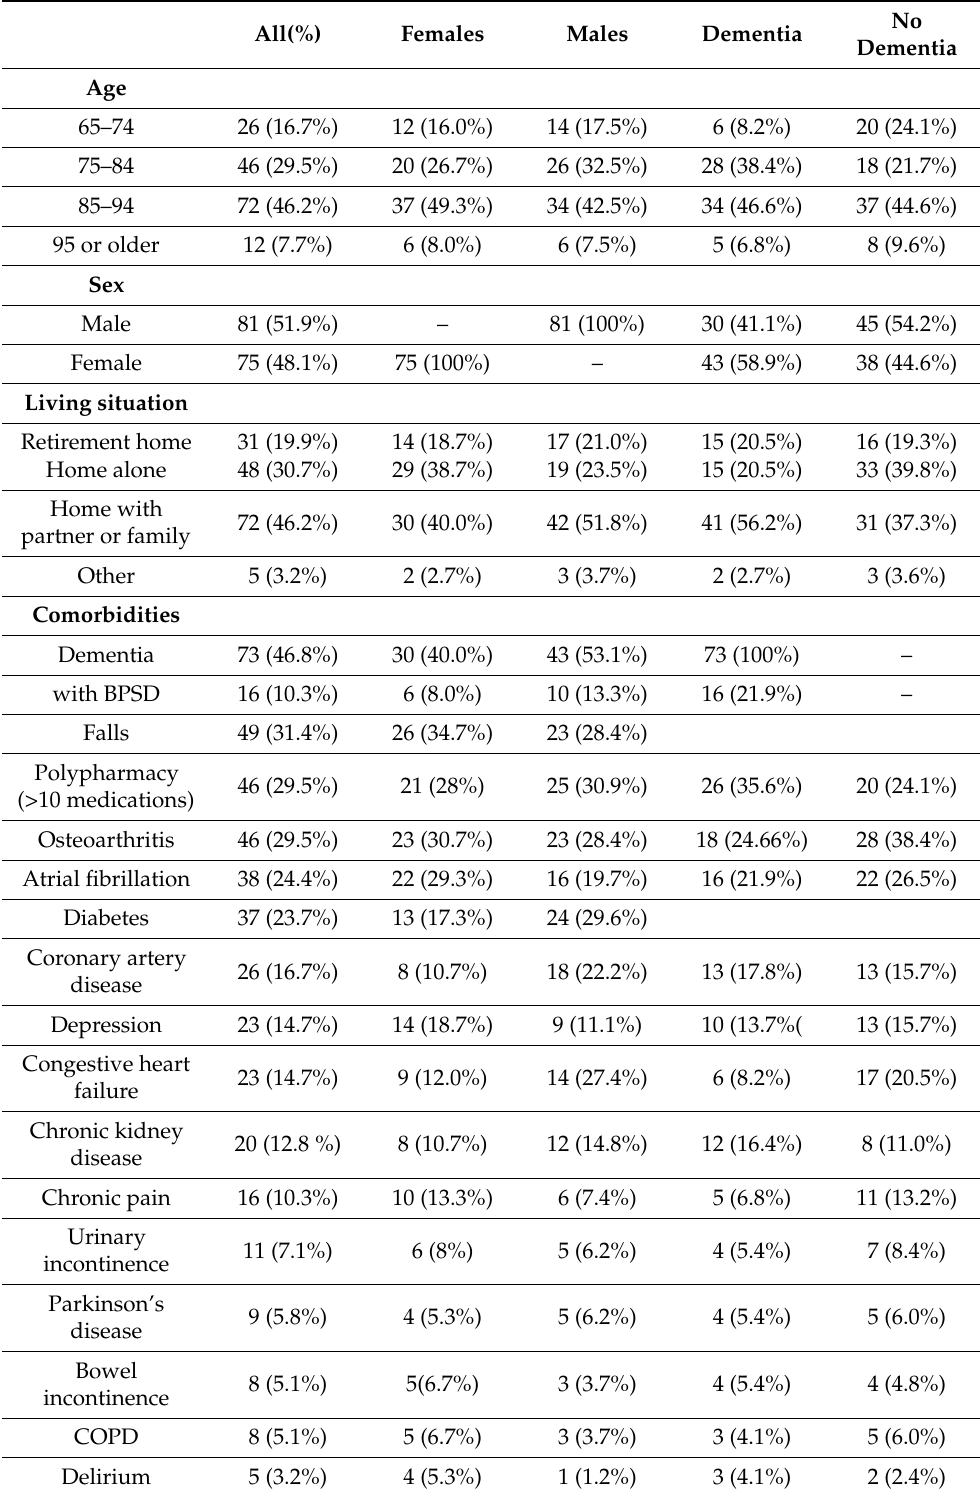
Table 1. Baseline